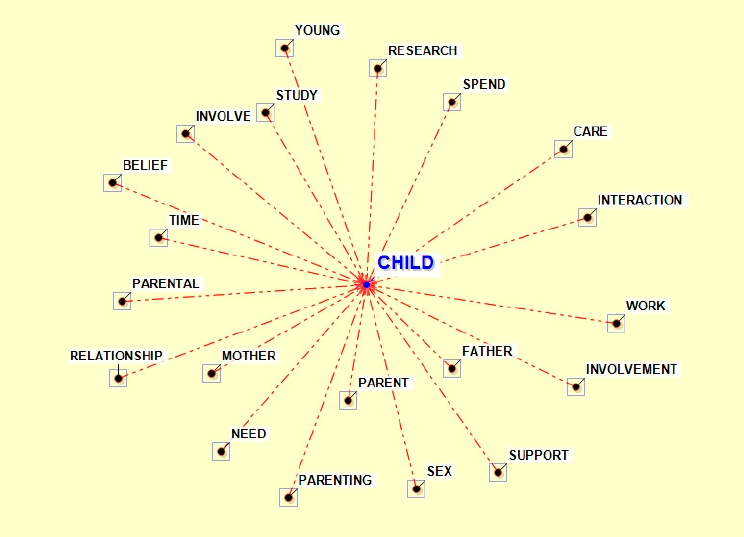
Figure 2. Radial diagram with “child”.